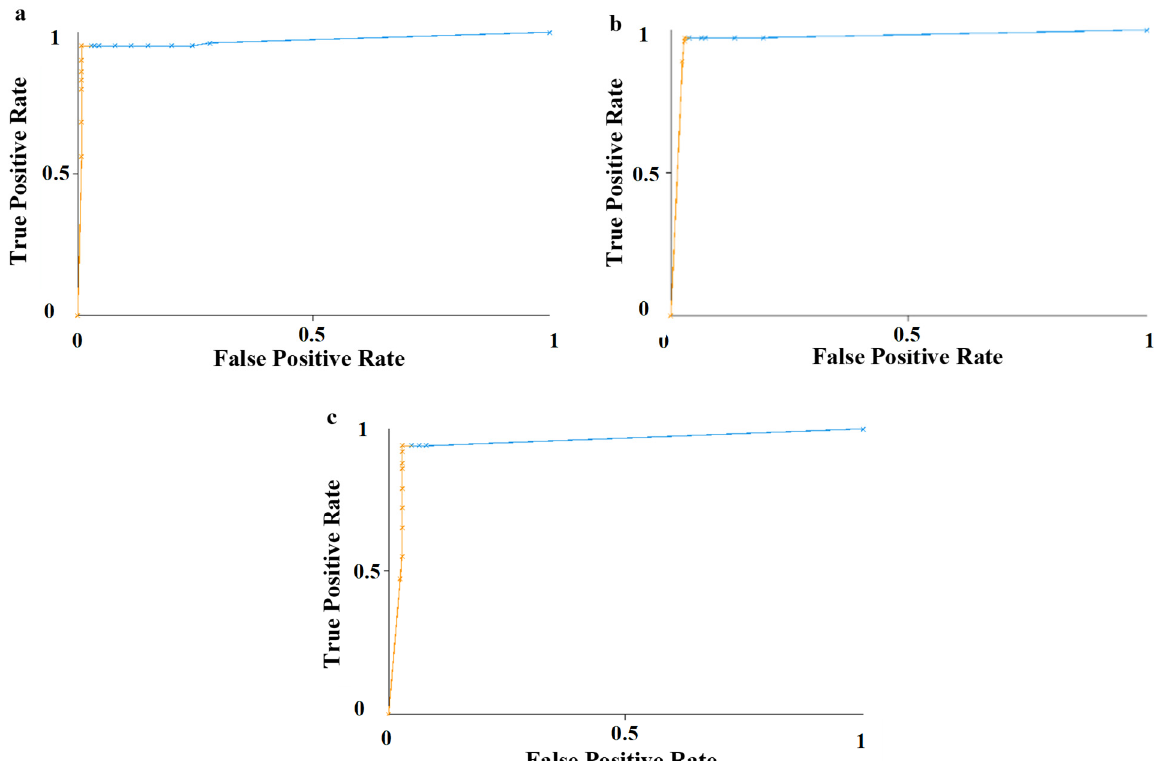
Figure 3. The ROC (Receiver Operating Characteristic) curves for the cultivar discrimination of plum kernels for a model built using the PART classifier based on textures selected from all color channels, ( a ) ‘Emper’, ( b ) ‘Kalipso’, ( c ) ‘Polinka’.